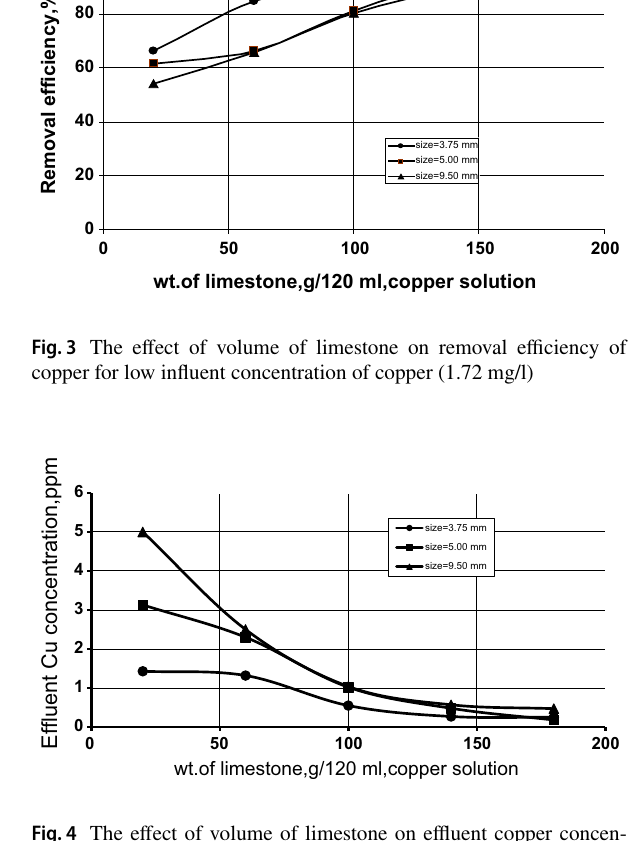
Fig. 4 The effect of volume of limestone on effluent copper concen- tration for high influent concentration of copper (7.04 mg/l)